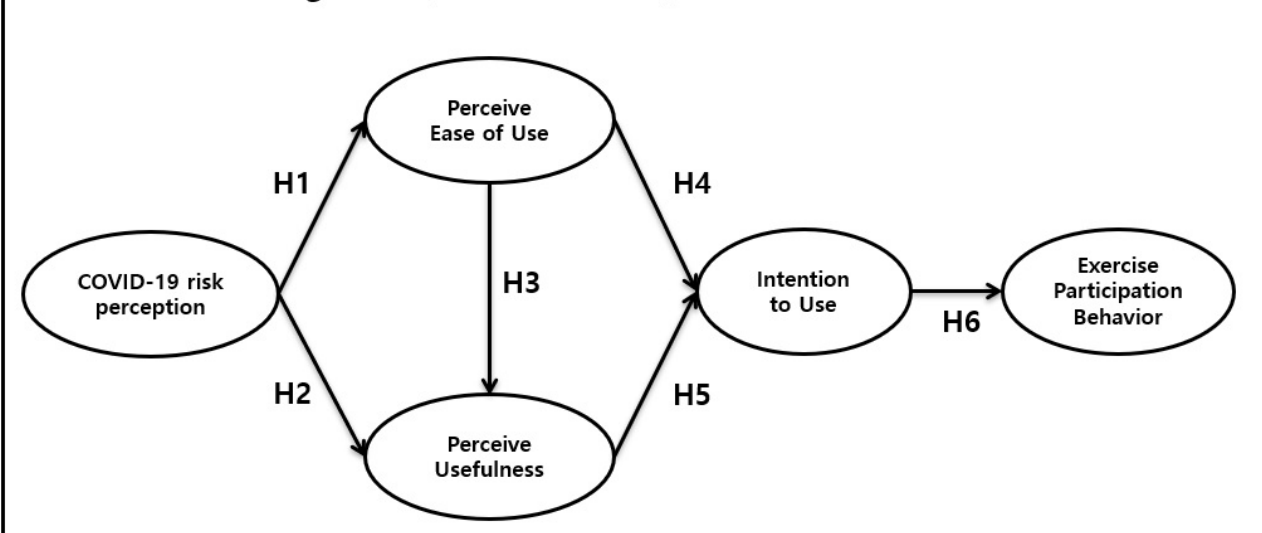
FIGURE 1. Research model. H1: Hypothesis 1; H2: Hypothesis 2; H3: Hypothesis 3; H4: Hypothesis 4; H5: Hypothesis 5; H6: Hypothesis